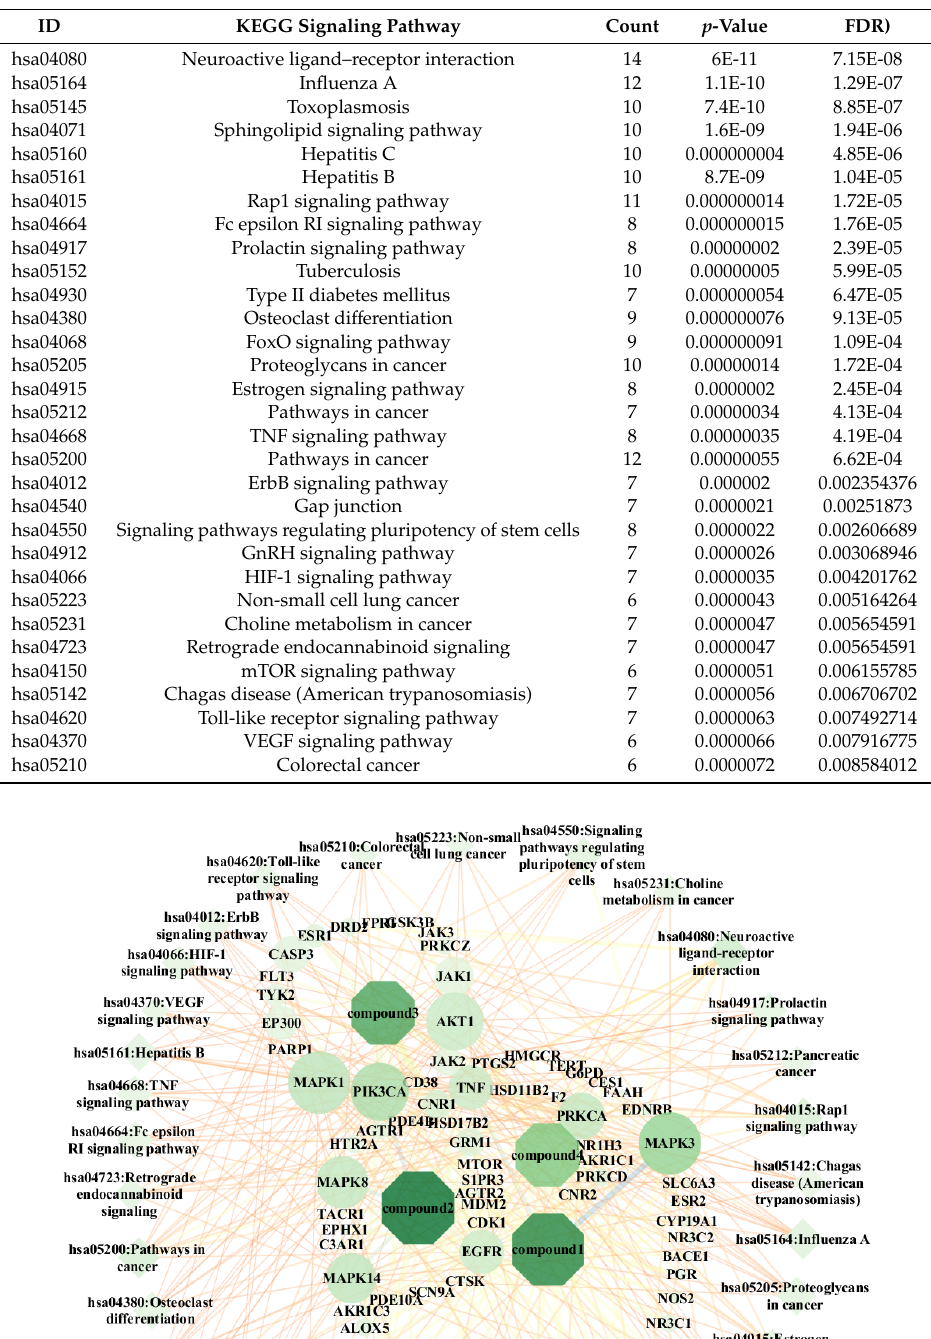
Table 2. KEGG signaling pathway in the database for annotation, visualization and integrated discovery (DAVID).